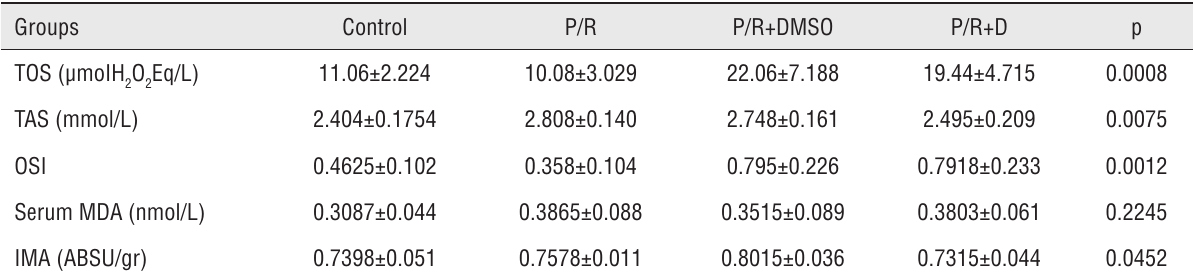
Table 2 - groups’ biochemical data.